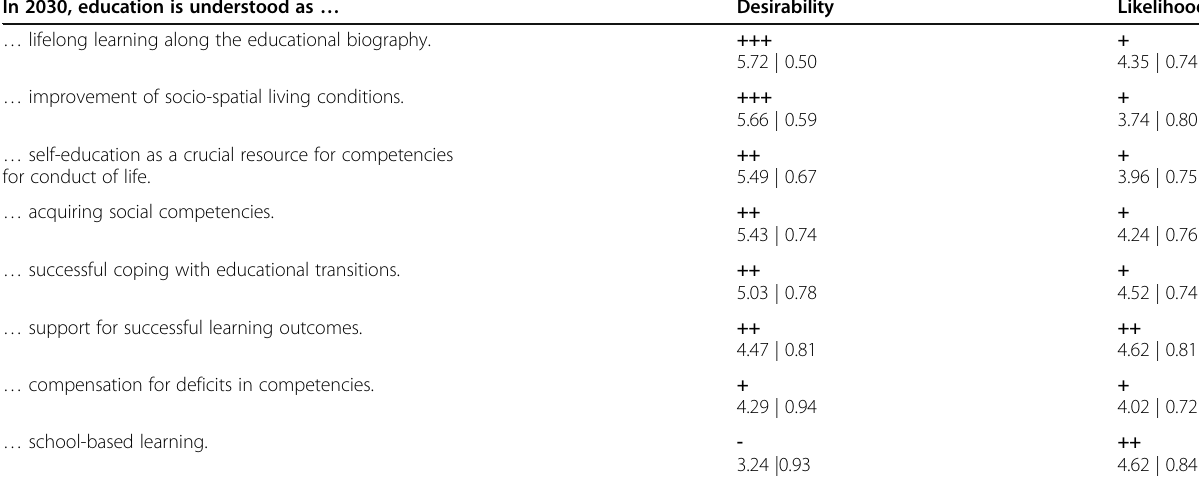
Table 4 Means and standard deviations for statements on ABI understanding of education In 2030, education is understood as … Desirability Likelihood